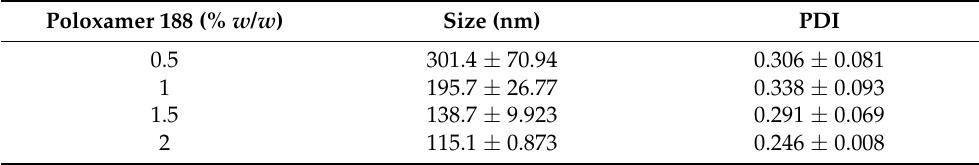
Table 1. Effect of Poloxamer 188 concentration on the size and PDI of SLNs ( n =